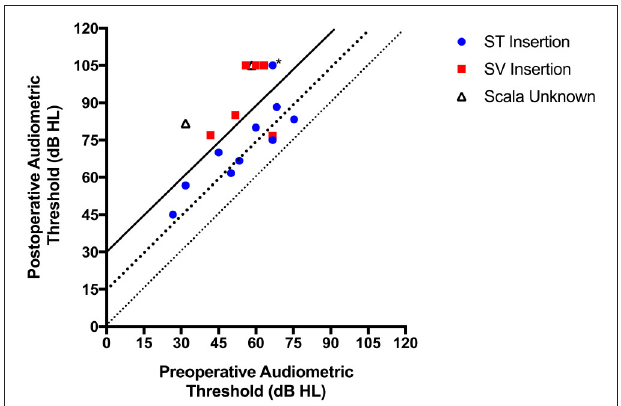
FIGURE 1 | Pre- and postoperative pure-tone thresholds; each symbol represents an individual patient. Scalar location of electrode, when available, has been denoted (the * represents the electrode abutting the basilar membrane). Diagonal lines are used to depict hearing preservation in relation to pure-tone average (PTA) shift bins as follows: PTA shift < 15dB, PTA shift between 15–30dB, and PTA shift >